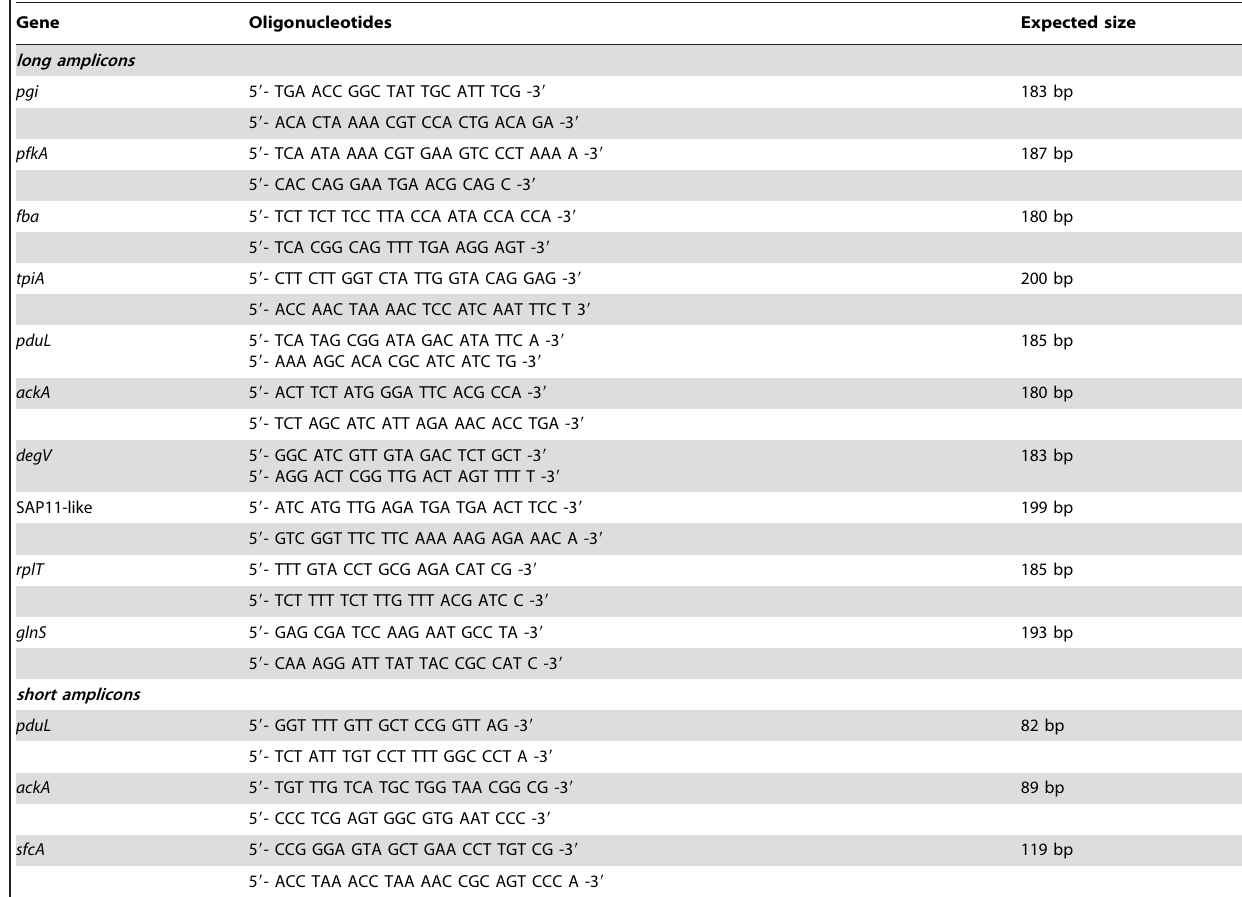
Table 1. Primer pairs used in (q)RT-PCR